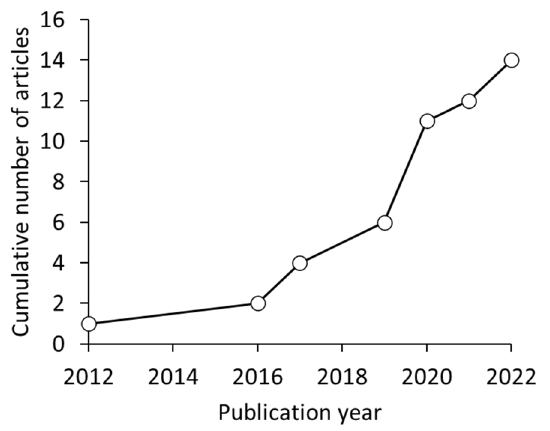
Figure 1. Publication trend on lacustrine macroplastics in lakes.